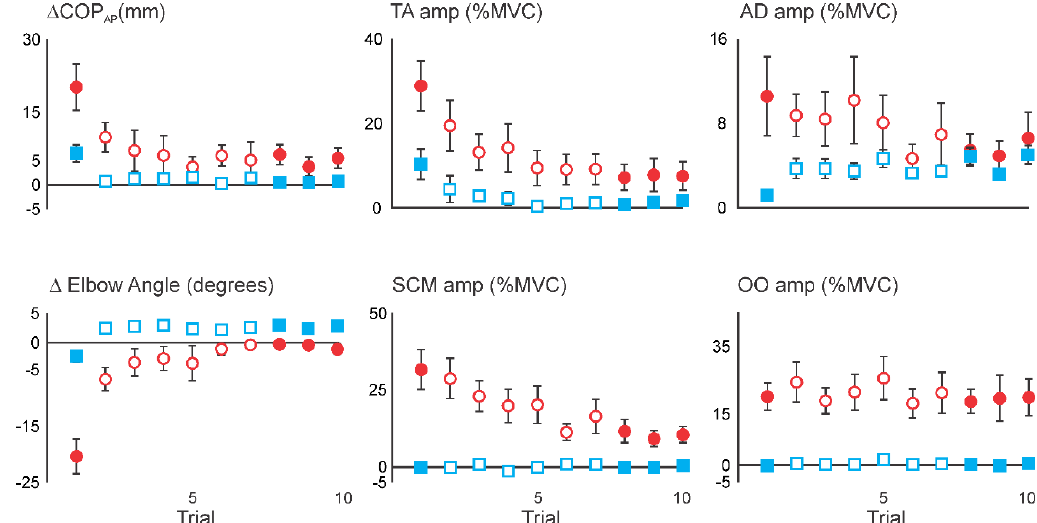
Figure 6. Trial-by-trial mean (SE) mechanical and muscle response amplitudes for all participants who received DISPLACEMENT (Blue squares) and COMBINED stimuli (Red circles) initially. Closed symbols indicate data points used in the statistical analysis. TA, tibialis anterior; AD, anterior deltoid; SCM, sternocleidomastoid; OO, orbicularis oculi; COP AP , center of pressure anterior–posterior; MVC, maximum voluntary contraction.